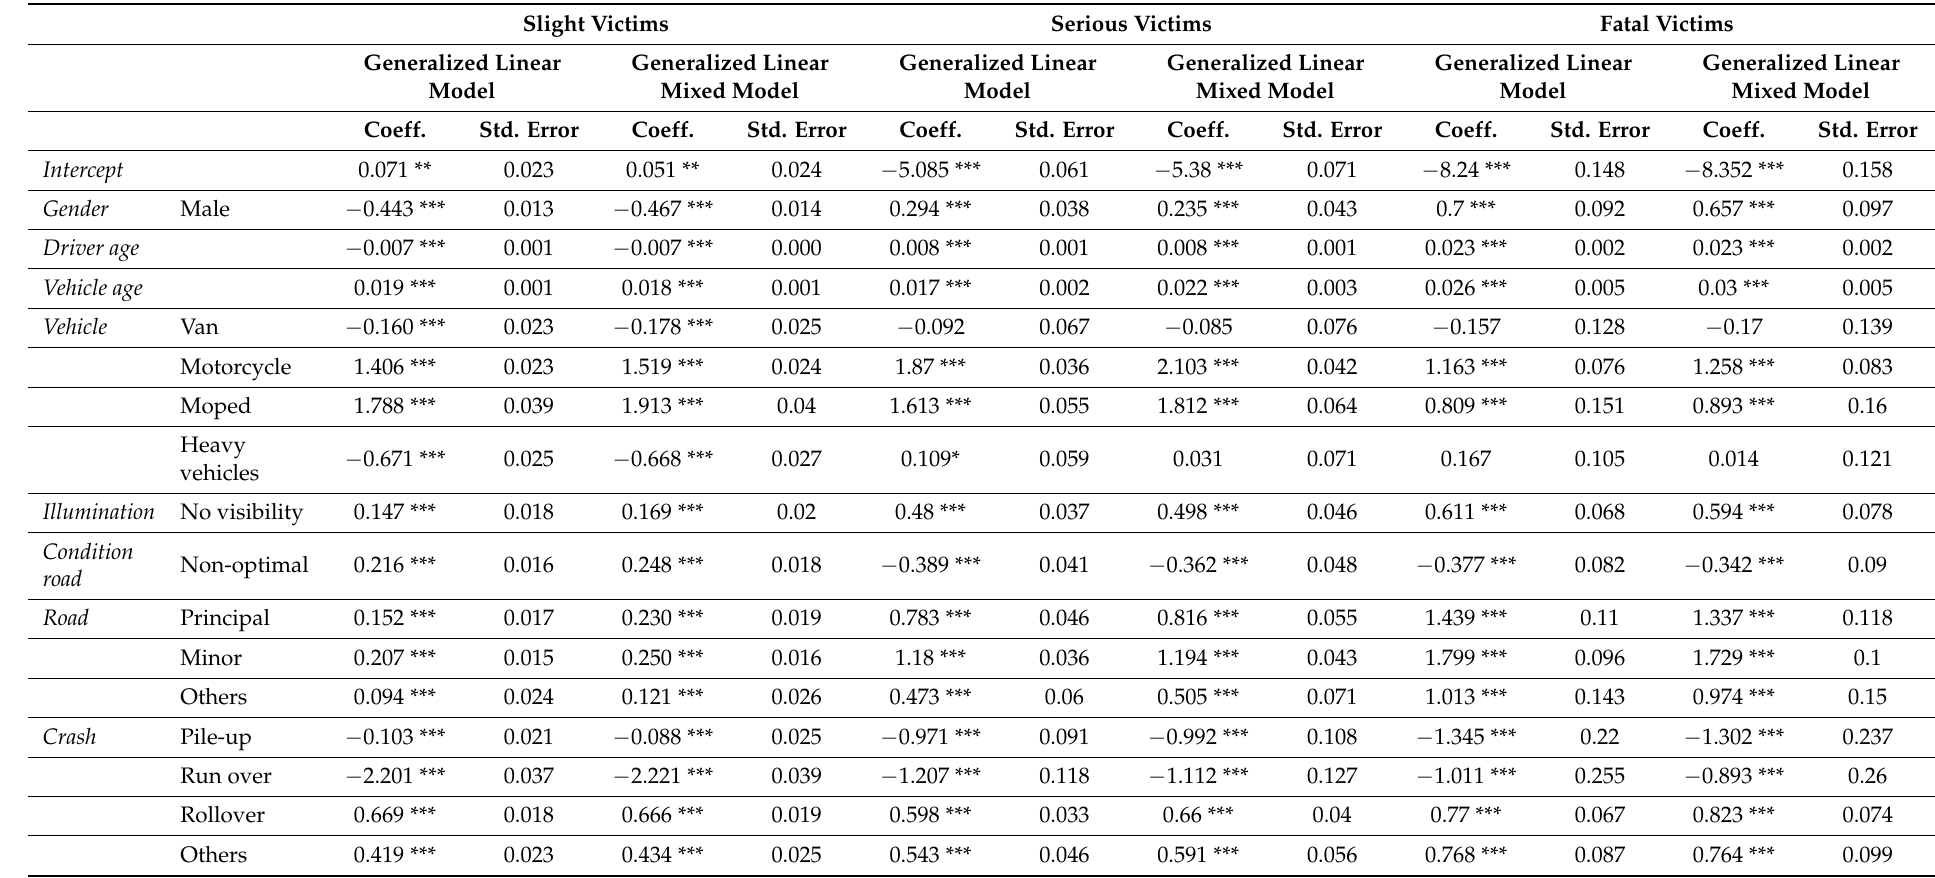
Table A1. Comparison of binomial regressions with and without random